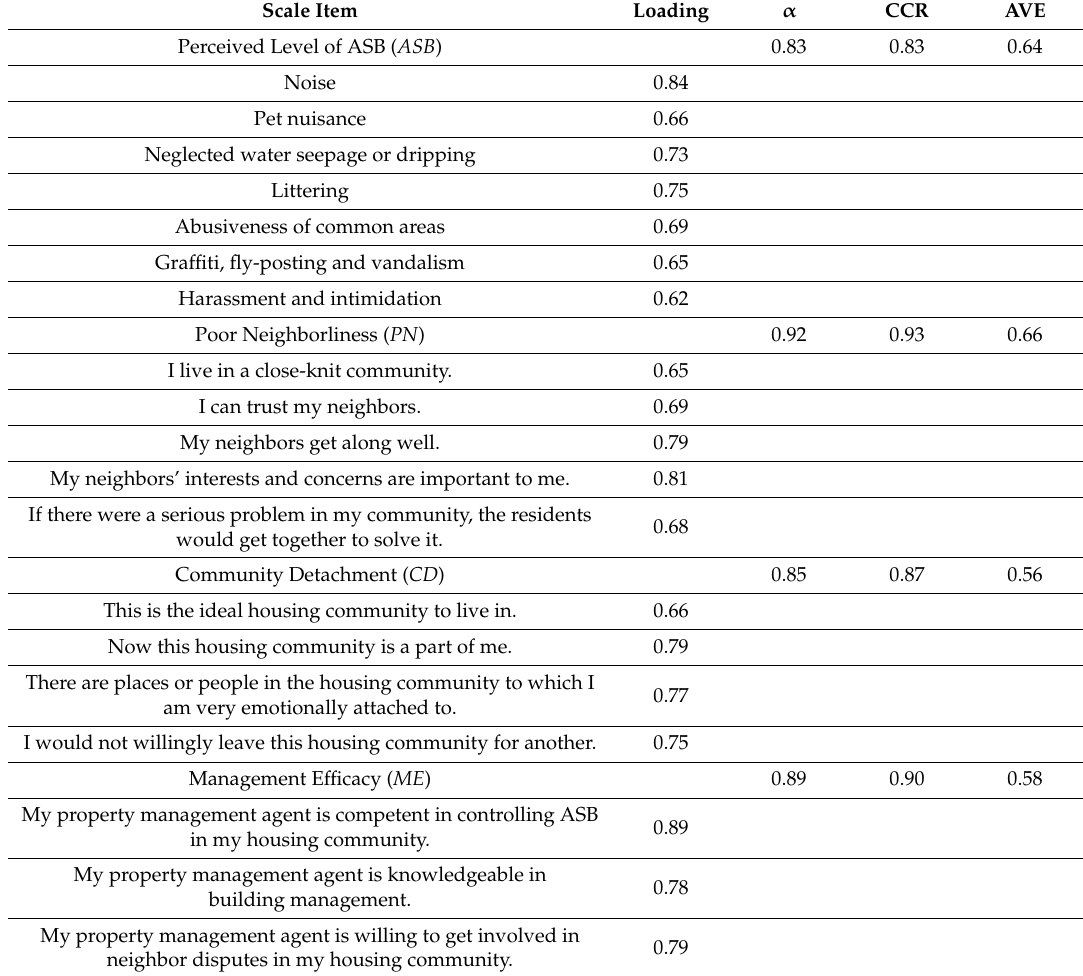
Table 3. Results of validity and reliability